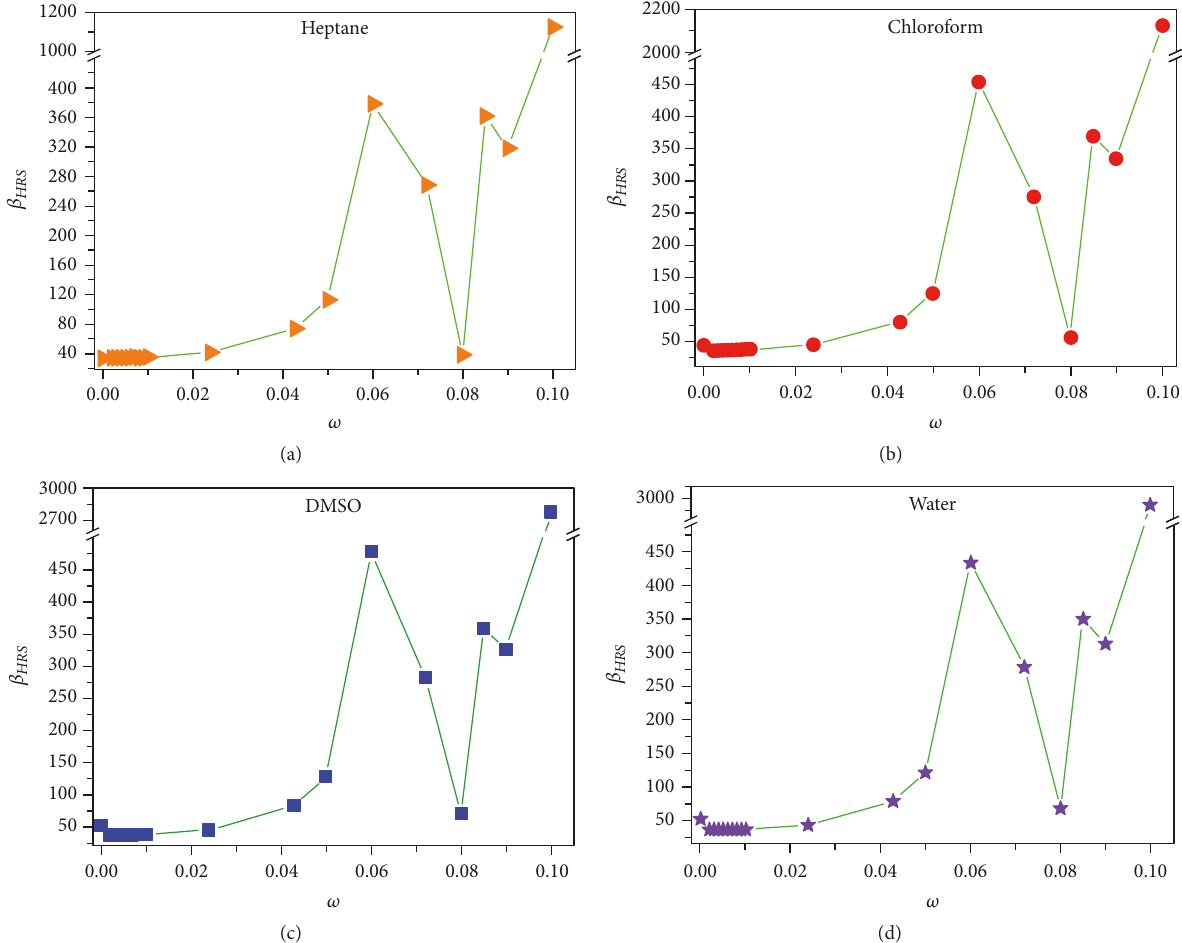
Figure 6: Dynamic HR Scattering first hyperpolarizability as function of the field frequency ( 𝜔 ) in a.u..